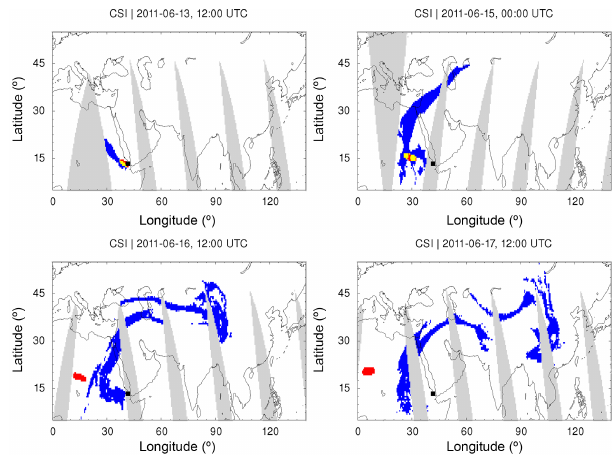
Figure 4. Same as Fig. 2, but for a unit simulation initialized at 20km altitude. This simulation agrees with the satellite observa- tions for about 48h, but disagrees at later times. Note that the time steps are partly different from those shown in Figs. 2 and